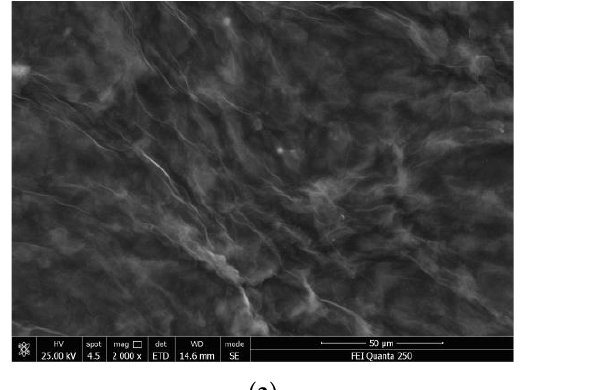
Figure 5. Film characterization: ( a ) Surface view; ( b ) Side view